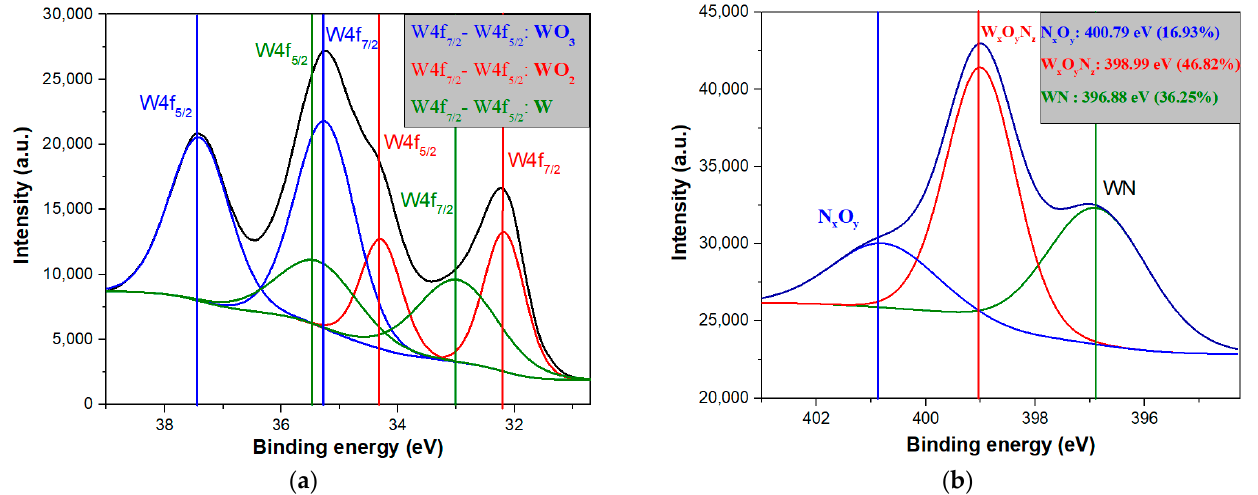
Figure 10. XPS deconvolution results for hybrid nanostructures obtained in plasma OFF condition in ( a ) W4f region ( b ) N1s region.